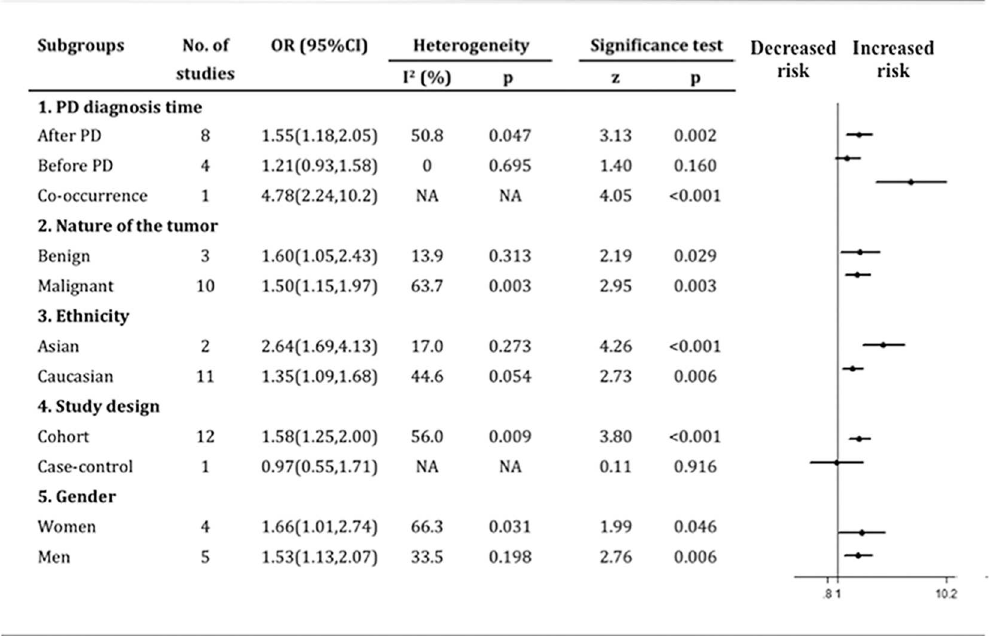
Fig 3. Pooled estimation on the risk of brain tumor in PD patients by subgroup